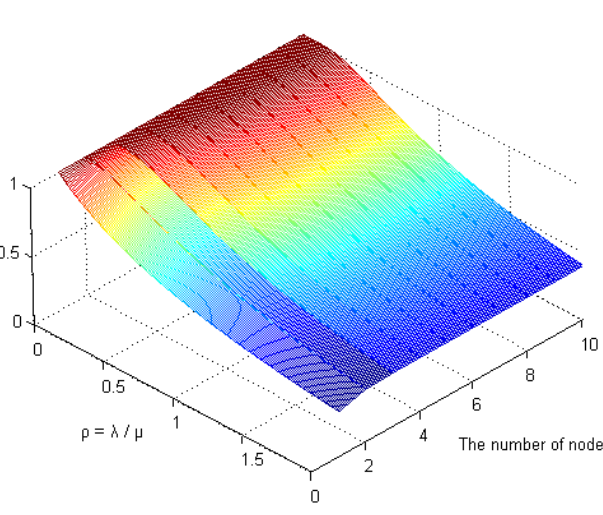
Figure 9. The steady-state availability.